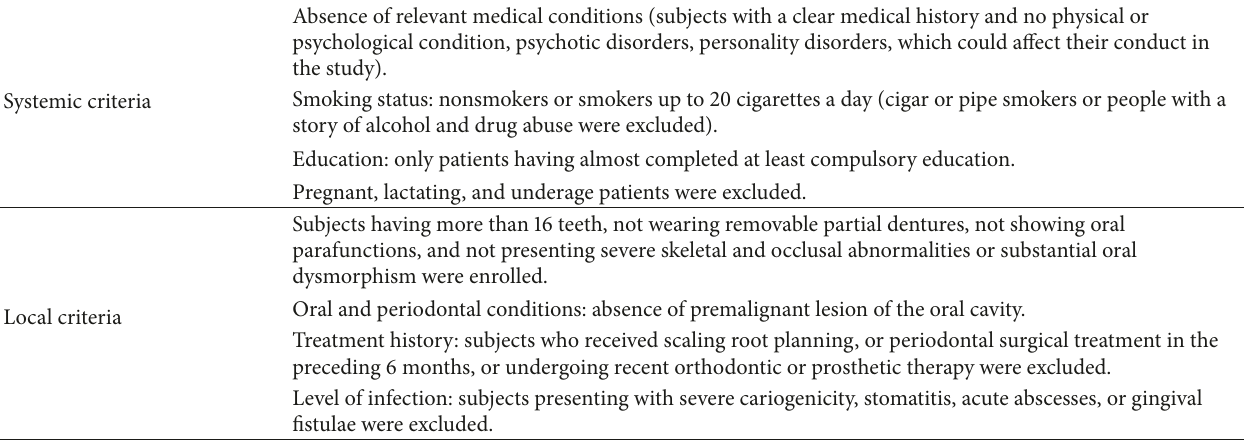
Table 1: Systemic and specific inclusion